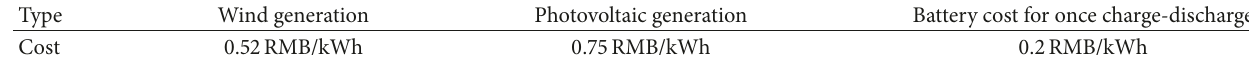
Table 5: Power cost for different generation type.